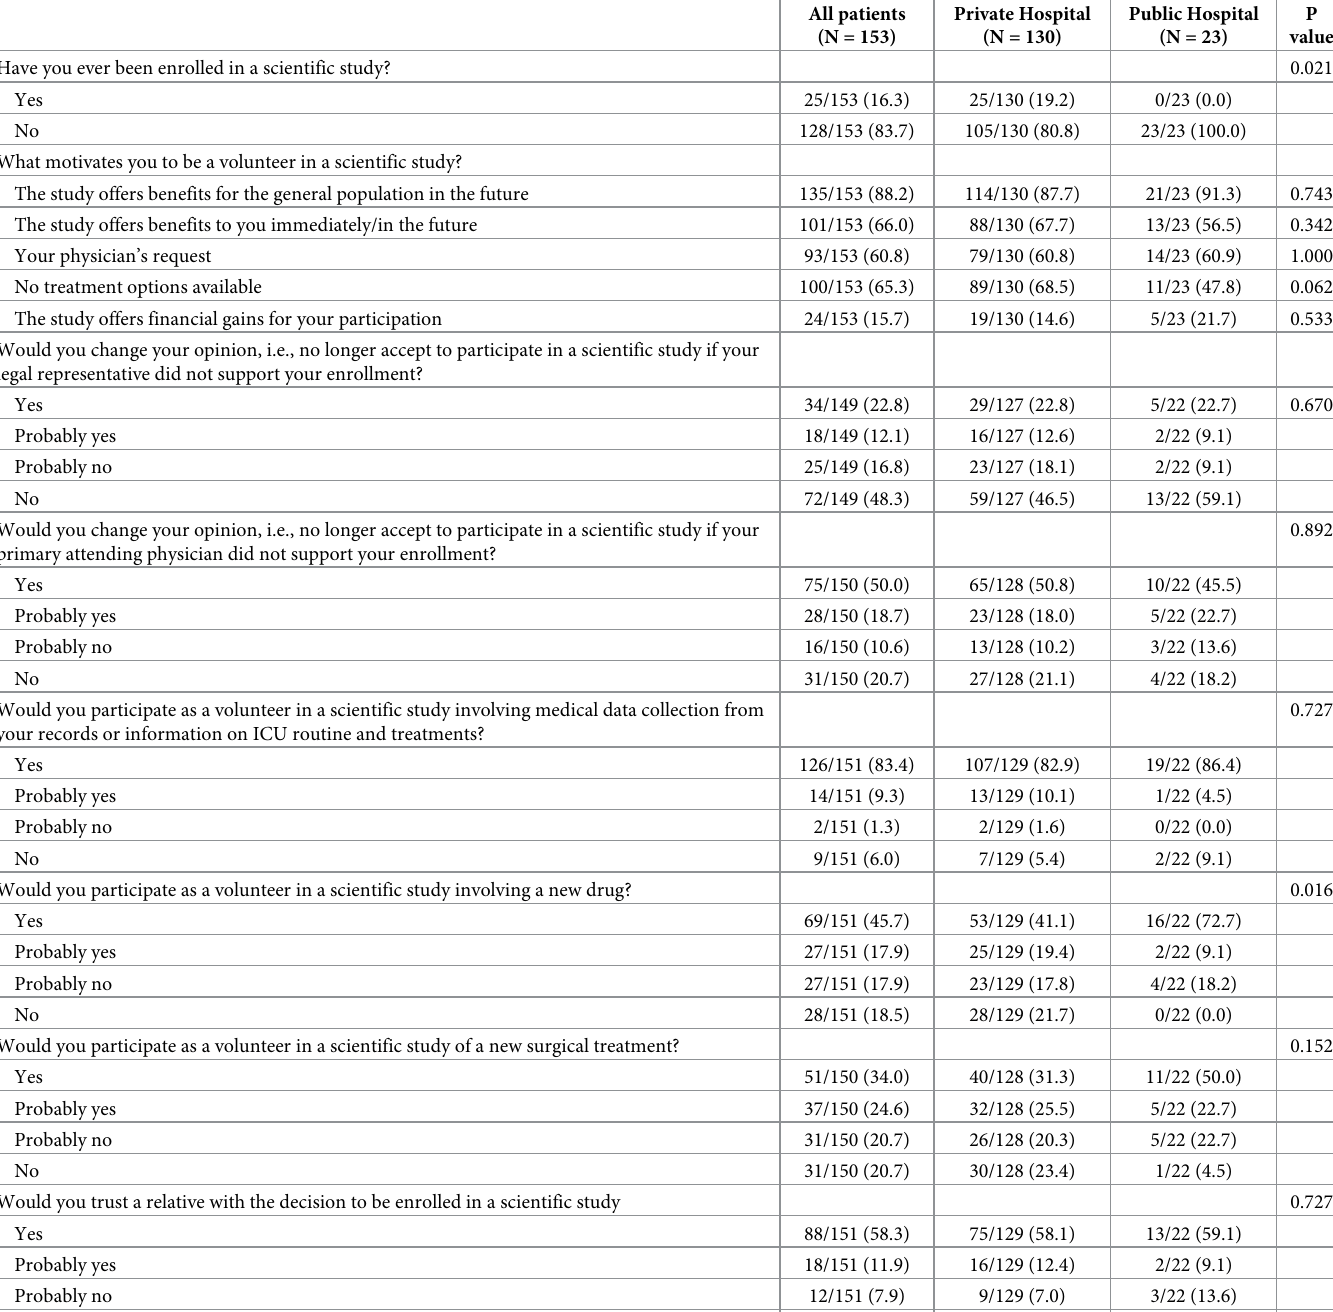
Table 2. Patients willing (Yes / Probably yes) to be enrolled in a scientific study opinion about participation in clinical research accordingly to the type of hospital. Data presented n º /total (%) #